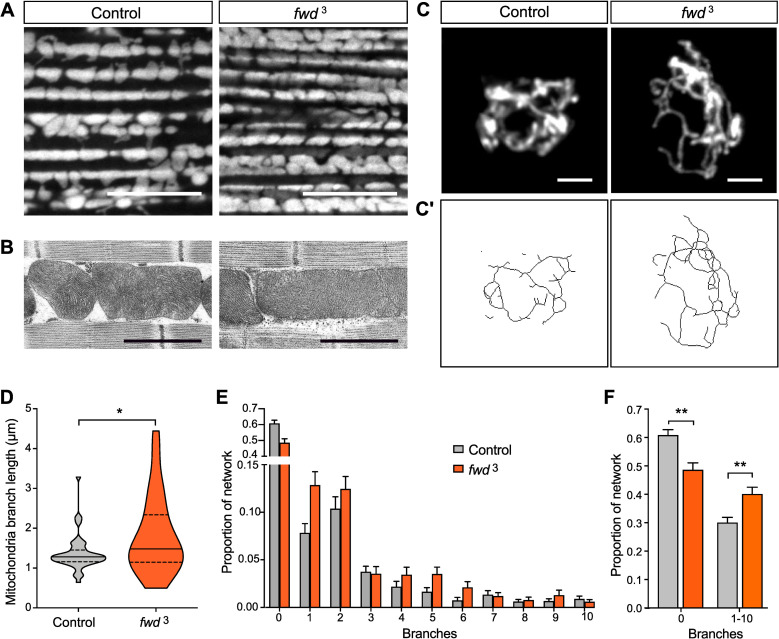
Loss of fwd causes excess mitochondrial fusion.(A) Confocal microscopy analysis of mitochondrial morphology, visualised using mitoGFP, in control and fwd mutant flight muscles. Scale bar = 10 μm. (B) Electron-microscopy analysis of mitochondrial structure in flight muscles. Scale bar = 1 μm. (C) Confocal microscopy analysis of mitochondrial network morphology (mitoGFP) in neuronal cell bodies from larval ventral ganglion of control and fwd mutants. Image shows a projected z-stack. Scale bar = 2 μm. (C’) Skeletonised image of mitochondrial network used for quantification. (D) Quantification of median mitochondrial branch length per cell. Violin plot indicating median (thick horizontal line) and quartiles (dashed lines). Significance was analysed by Mann-Whitney test. (E) Frequency distribution plot of mitochondrial network connectivity (number of connected branches) per cell. N = 46 (Control) and 54 (fwd3). (F) Chart summarising quantification of connectivity shown in E, plotting the proportion of individual mitochondria (0 branches) and connected mitochondria (1–10 branches) relative to the total number of networks per cell. Significance was analysed by Kruskal-Wallis test with Dunn’s post-hoc correction for multiple comparisons. * P<0.05, ** P<0.01. Full genotypes are given in S1 Table.